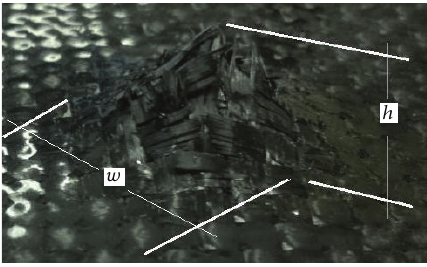
Figure 6: Pyramidal damage pattern of woven carbon fabric